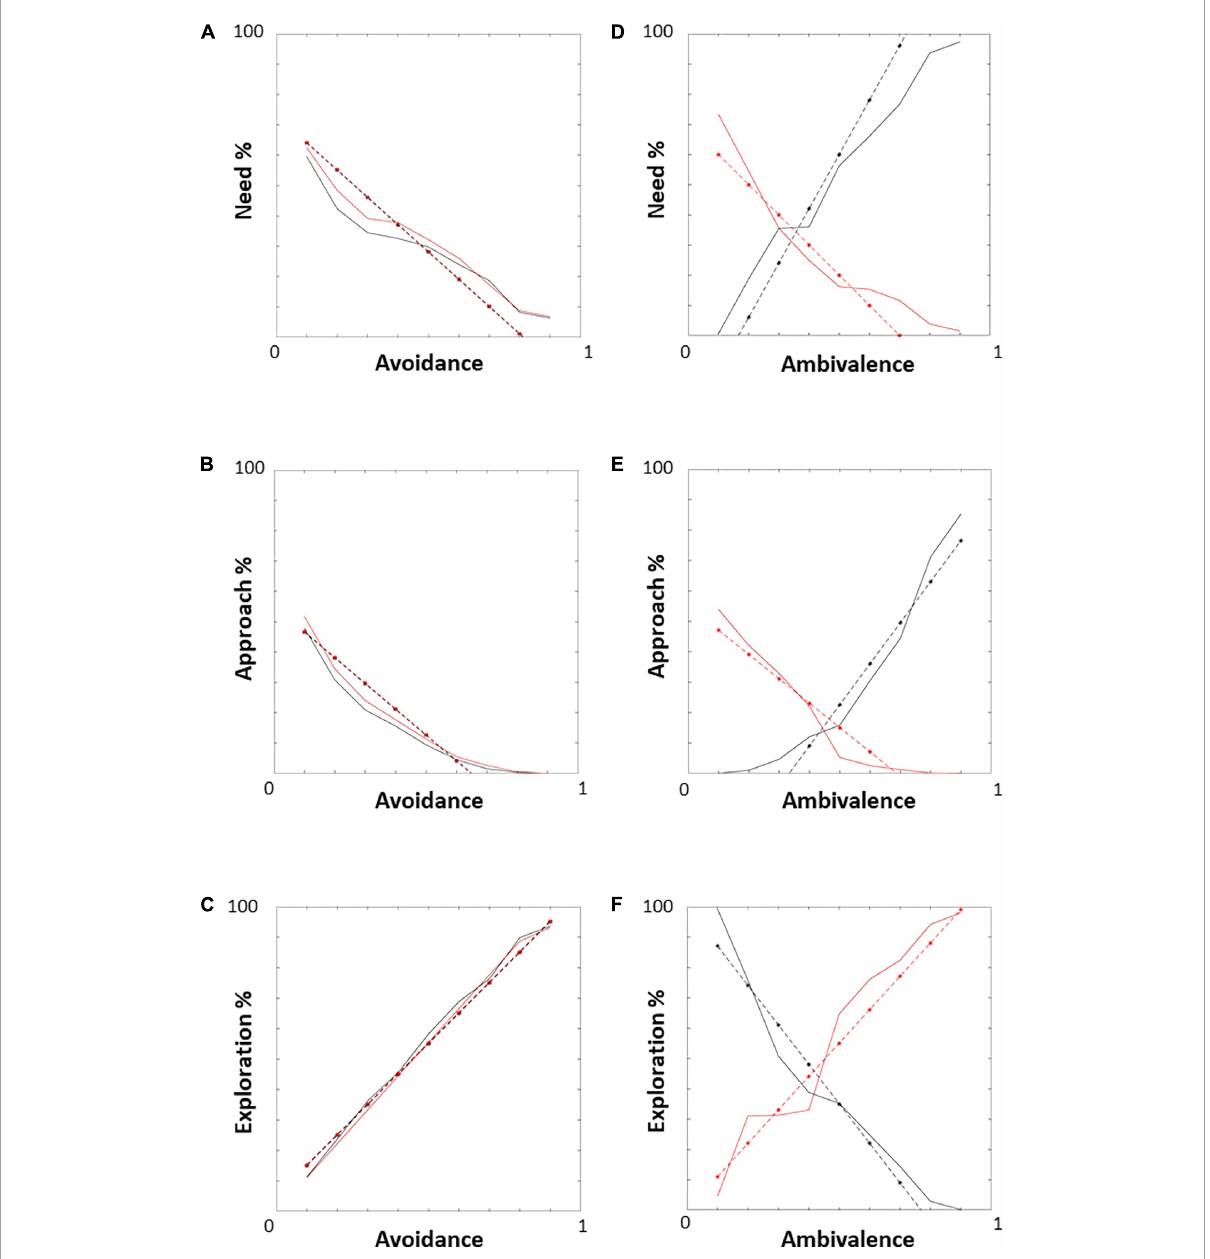
FIGURE13 Need, approach, and exploration trends: simulated vs. expected. The graphs represent the simulated need, approach, and exploration trends (solid) compared to the expected ones (dashed; in black for the child, in red for the caregiver) in the avoidant (A–C) and ambivalent (D–F) cases. All simulated trends match those